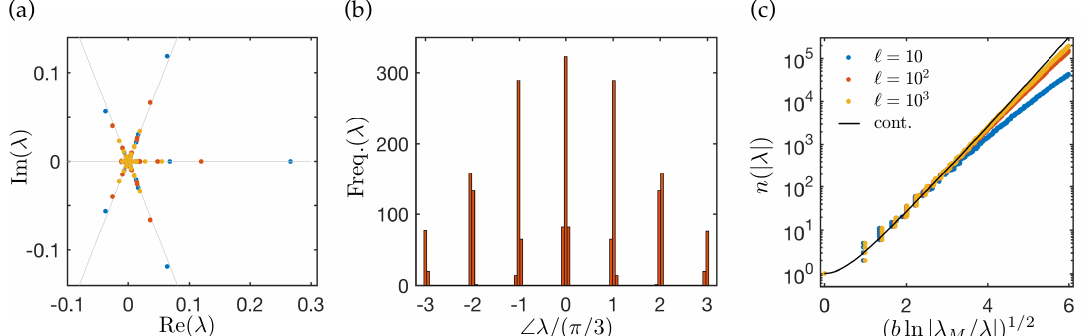
Figure 3: Spectral properties of ρ T A for two adjacent intervals with length (cid:96) on an infinite chain. (a) Many-body eigenvalues are plotted over the complex plane. The solid gray lines are guides for the eyes and a hint for the phase quantization. (b) Histogram of complex phases of eigenvalues which indicates nearly quantized phases in units of π/ 3. (c) Tail distribution function of modulus of eigenvalues. The solid line is the analytical result (73b). To compute the many-body spectrum, we truncate the single-particle spectrum with the first 28 largest (in euclidean distance from ± 1 on the complex plane)